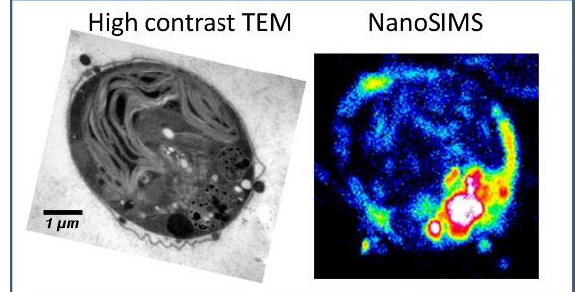
Figure 2. Ultrastructural analysis applying high-contrast TEM combined with elemental distribution applying NanoSIMS. Reprinted from Penen et al.; JTEMB 37, p. 62–68 (2016); with permission from Elsevier [100].